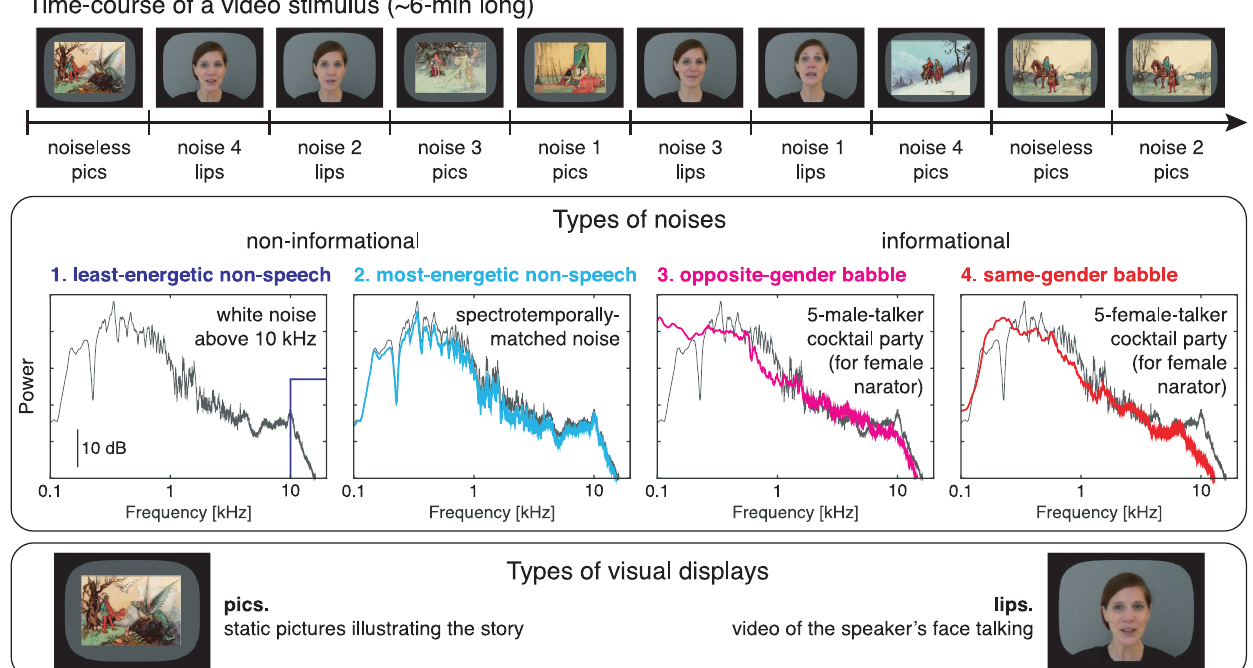
Fig 1. Illustration of the experimental material used in the neuroimaging assessment. Subjects viewed four videos of approximately 6 min in duration in which a different narrator (two females, two males) told a story. Each video was divided into 10 blocks to which experimental conditions were assigned. There were two blocks of the noiseless condition, and eight blocks of speech-in-noise conditions: one block for each possible combination of the four types of noise and two types of visual display. The interference introduced by the noise was either informational or not and varied in terms of degree of energetic masking. Power spectra are presented for all types of noise (colored traces) and one of the attended speeches (gray traces; here, that of a female narrator). The visual display provided visual speech information (lips) or not (pics).